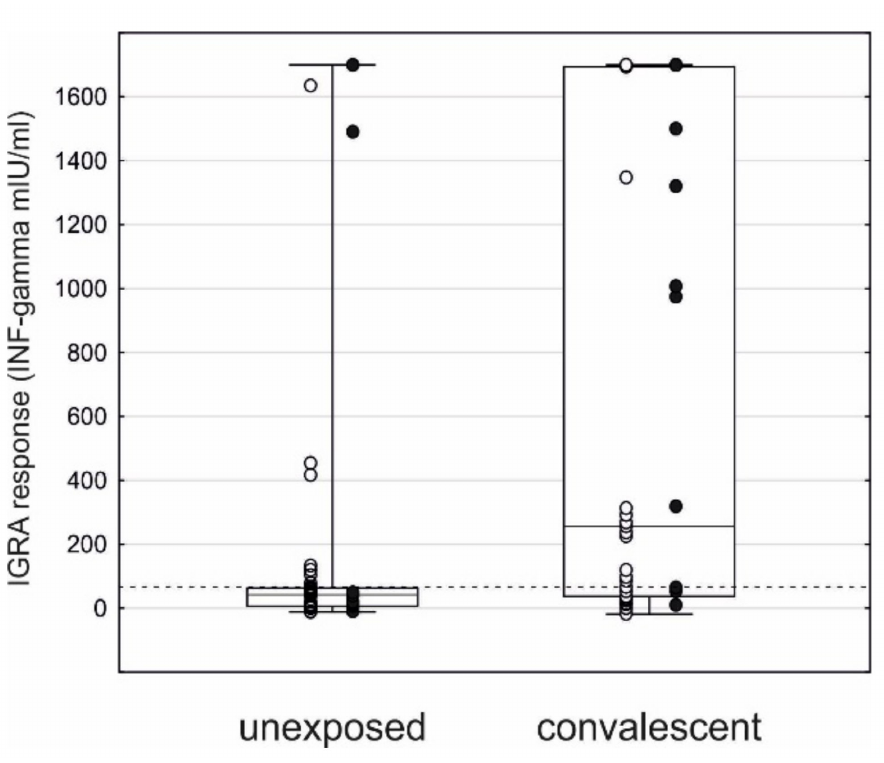
Figure 1. IGRA response in SARS-CoV-2 convalescent (median, IQR: 257, 37–1693 mIU/mL) and reference patients (42, 6–64, p < 0.001). Raw data points: